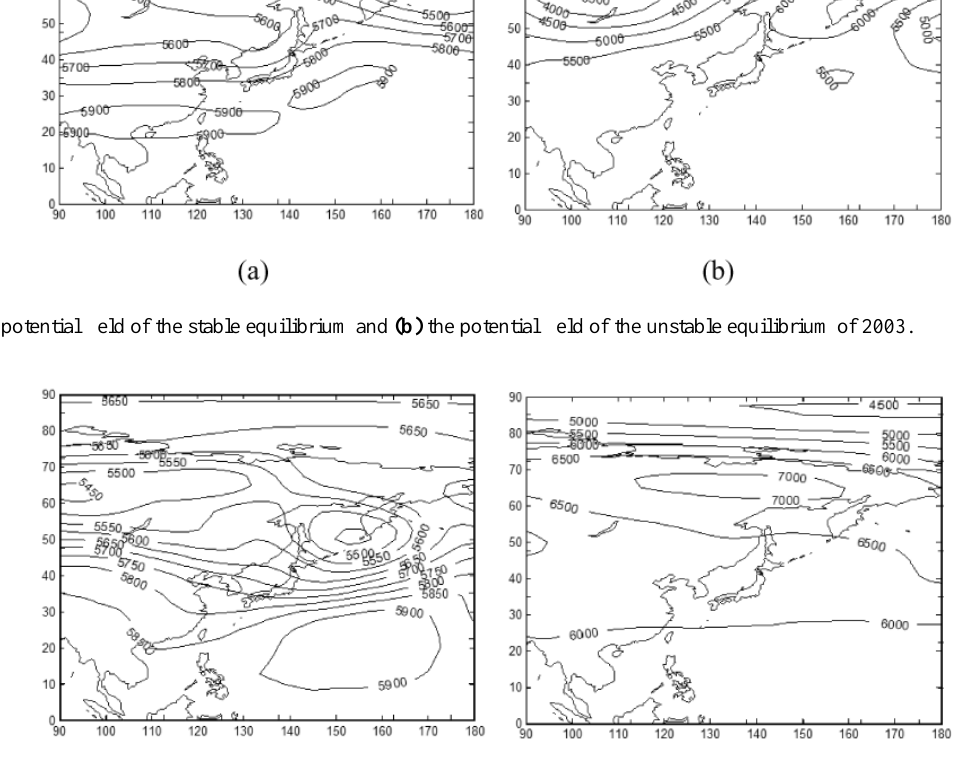
Similarly, as for equations of the summer SH in 2006, the roots of equilibrium can be solved. Its seven roots are shown in Table